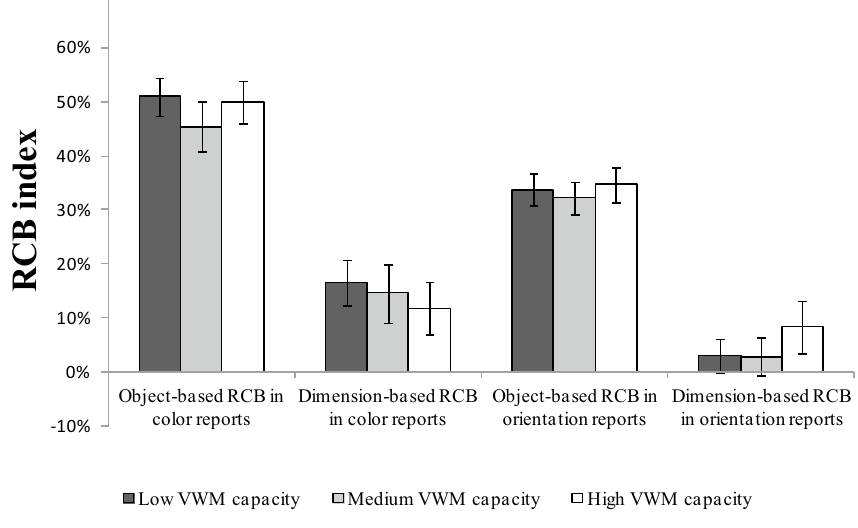
Figure 6. RCB indexes for the high VWM capacity, medium VWM capacity, and low-VWM-capacity groups, separated according to each reported feature in the different cue tasks. “Object-based RCB in color reports” refers to the RCB for the color report trials for the object-based cue task. “Dimension-based RCB in color reports” refers to the RCB for the color report trials for the dimension-based cue task. “Object-based RCB in orientation reports” refers to the RCB for the orientation report trials for the object-based cue task. “Dimension- based RCB in orientation reports” refers to the RCB for the orientation report trials for the dimension-based cue task. Mean values with error bars show the standard errors of the